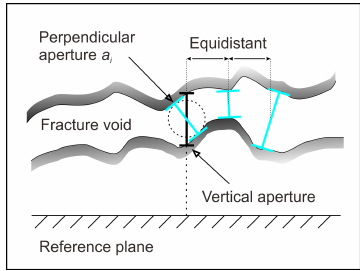
Figure 3. Conceptual illustration of different mechanical aperture definitions and the estimation method applied in this study (indi- cated in blue); modified from Konzuk and Kueper